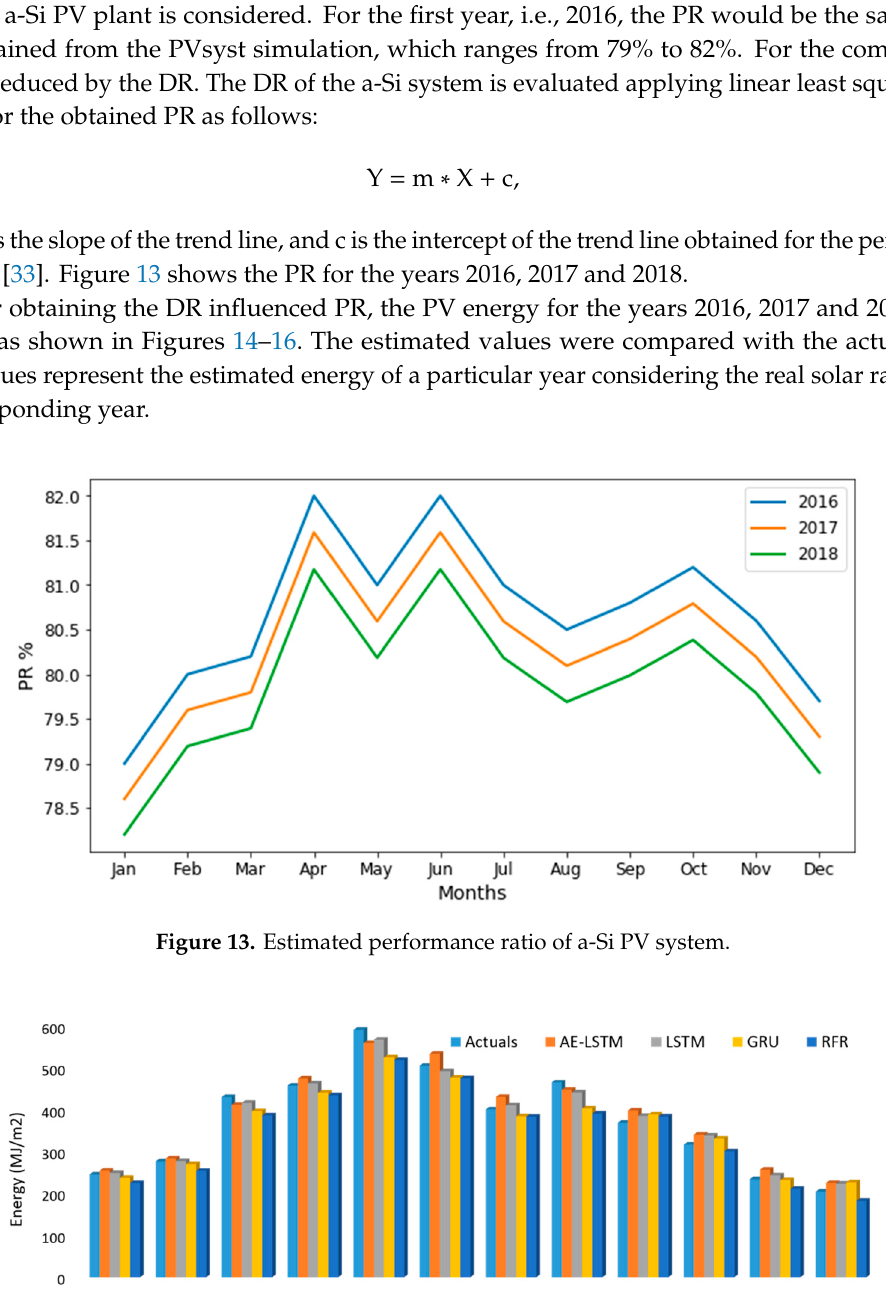
Figure 15. PV energy potential estimation for the year 2017.